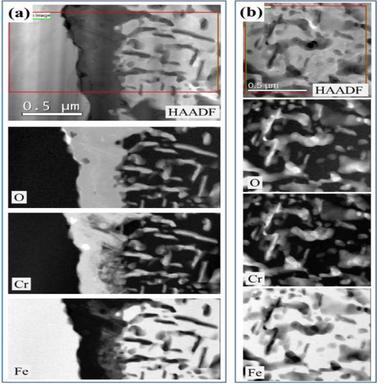
EELS analysis results (a) at the matrix-internal oxide layer interface, (b) in the internal oxide layer of T91 after exposure in SCW at 600 °C for 1500 h.